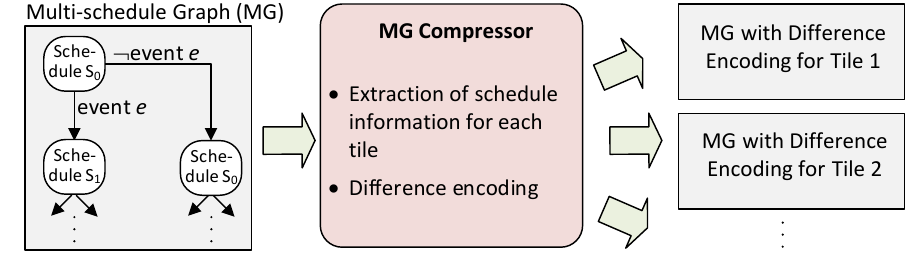
Figure 5. Multi-schedule graph